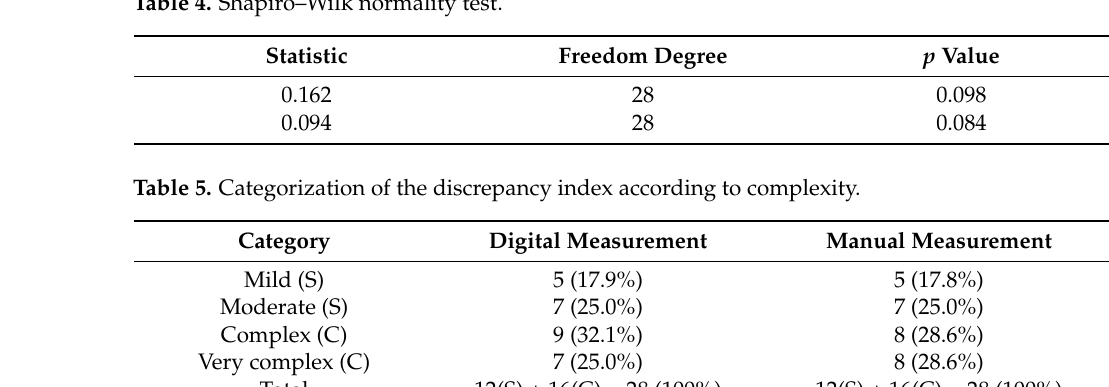
Table 4. Shapiro–Wilk normality test.